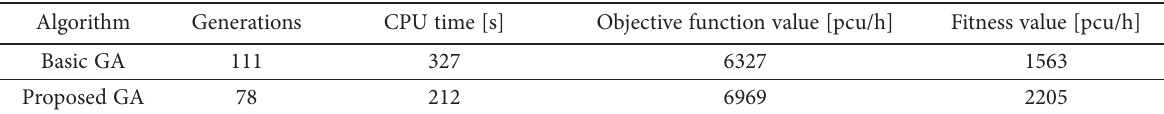
Table 2. Results of two GAs